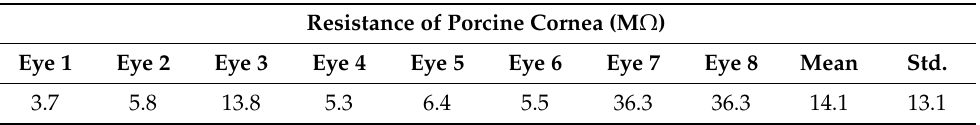
Table 2. Resistance of porcine cornea, measured using two electrodes of the device as measure- ment probes.